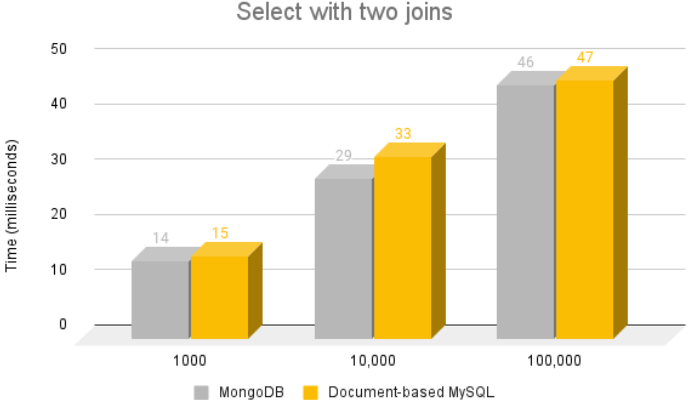
Figure 7. Execution times for the select with the two joins operation.